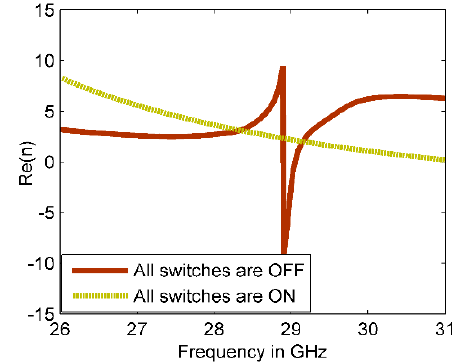
Figure 4. The real index of refraction of the reconfigurable CSR structure.